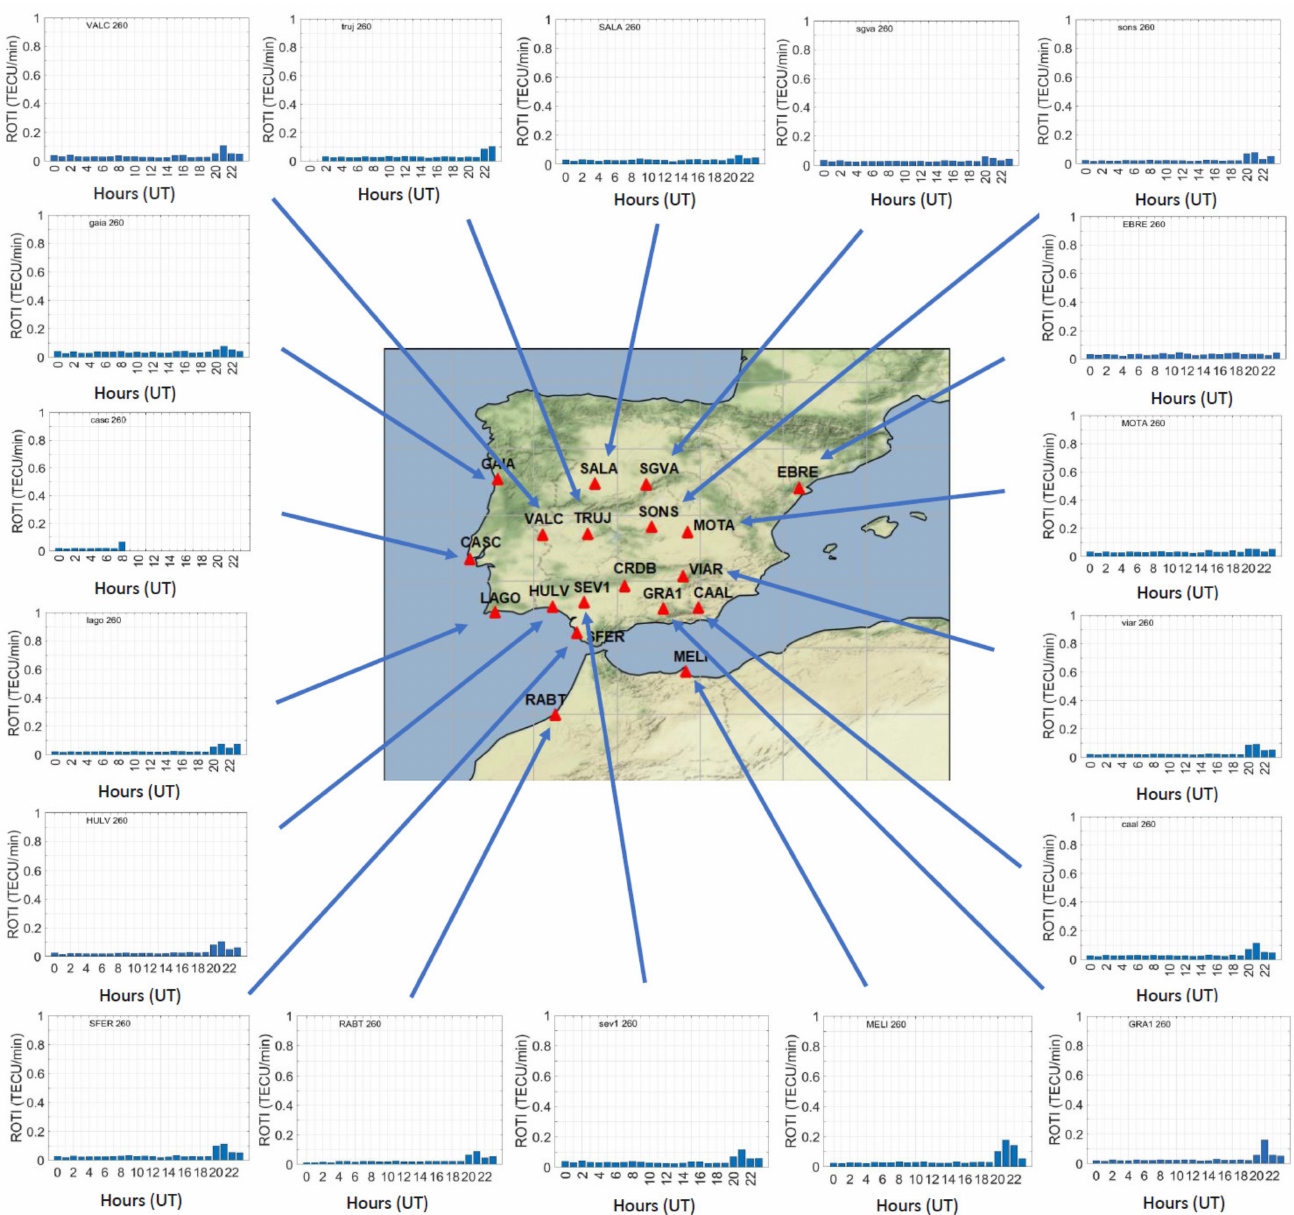
Figure 6. Map of receiver stations and hourly averaged ROTI plots during the day of the main phase of the 17–18 September 2021 geomagnetic storm (24 h on 17 September 2021): GAIA (41.1 N, 8.6 W), SALA (41.0 N, 5.7 W), SGVA (40.9 N, 4.1 W), EBRE (40.8 N, 0.5 E), VALC (39.4 N, 7.2 W), TRUJ (39.5 N, 5.9 W), SONS (39.7 N, 4.0 W), MOTA (39.5 N, 2.9 W), CASC (38.7 N, 9.4 W), LAGO (37.1 N, 8.7 W), HULV (37.3 N, 6.9 W), SEV1 (37.4 N, 6.0 W), CRDB (37.9 N, 4.8 W), VIAR (38.2 N, 3.0 W), SFER (36.5 N, 6.2 W), GRA1 (37.2 N, 3.6 W), CAAL (37.2 N, 2.5 W), RABT (34.0 N, 6.9 W), MELI (35.3 N, 2.9